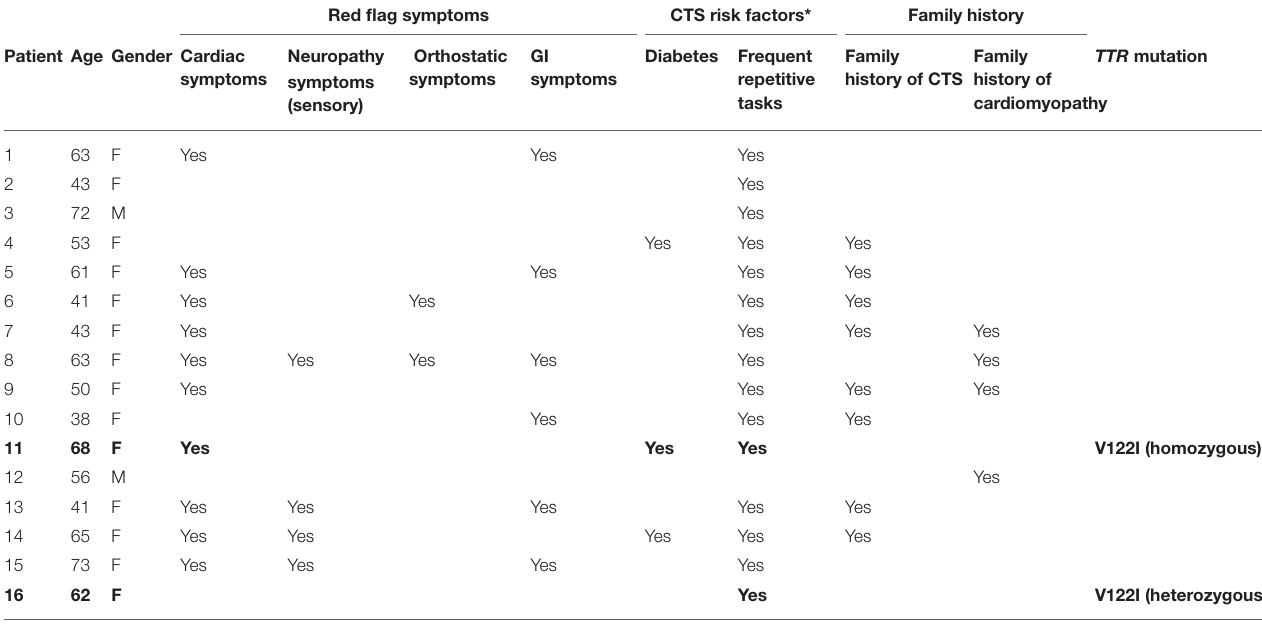
TABLE 1 | Results of TTR mutation screening, with red flag symptom, CTS risk factors, and family history of CTS and cardiomyopathy. Red flag symptoms CTS risk factors* Family history